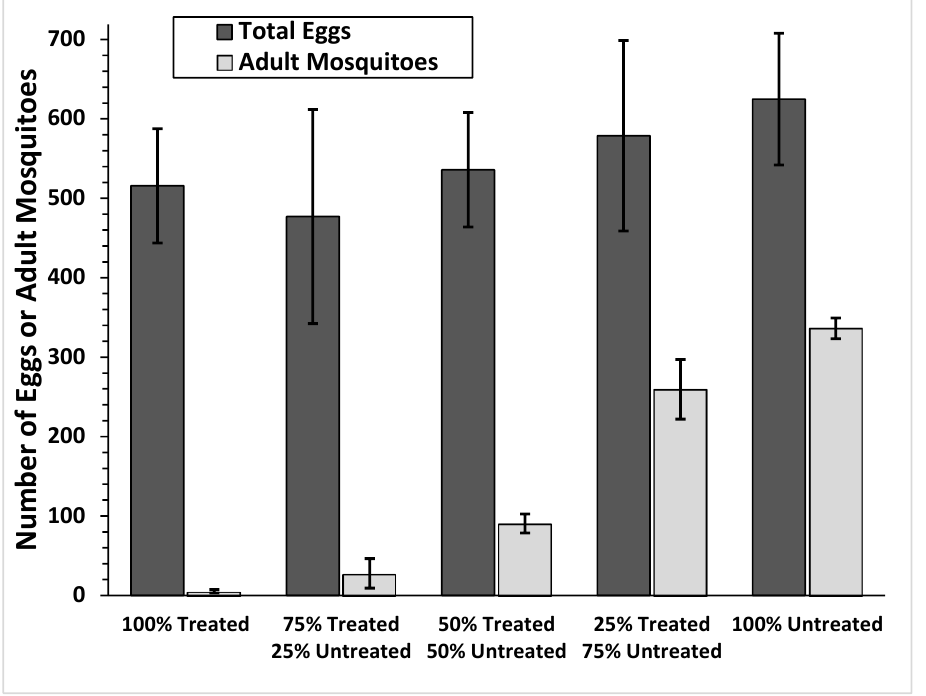
Figure 4. Total number of Ae. aegypti eggs laid and adults emerged using five different treatments: (a) 100% Treated—All 4 mosquito breeding cups treated with mosquitocidal chips containing 0.01% pyriproxyfen; (b) 75% Treated 25% Untreated—3 of 4 cups treated with mosquitocidal chips; (c) 50% Treated 50% Untreated—2 of 4 cups treated with mosquitocidal chips, (d) 25% Treated 75% Untreated—1 of 4 cups treated with mosquitocidal chips, and (e) 100% Untreated - none of 4 mosquito breeding cups treated with mosquitocidal chip. Error bars represent ± SEM. Table 1. Oviposition in pyriproxyfen-treated and untreated water containers in cages with Aedes aegyptii f emales. Treated Containers Untreated Containers Treatment